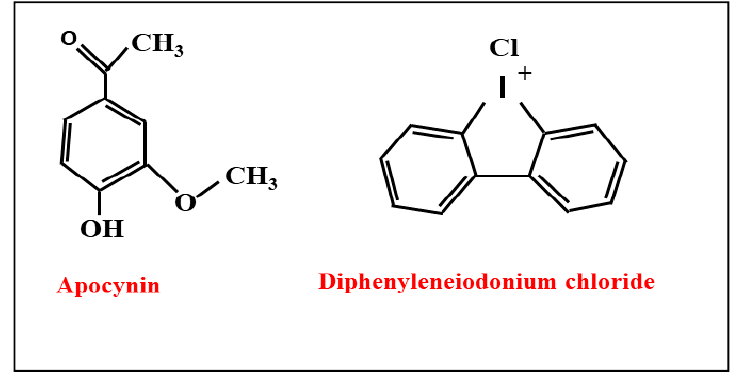
Figure 1. Chemical structures of apocynin and diphenyleneiodonium.